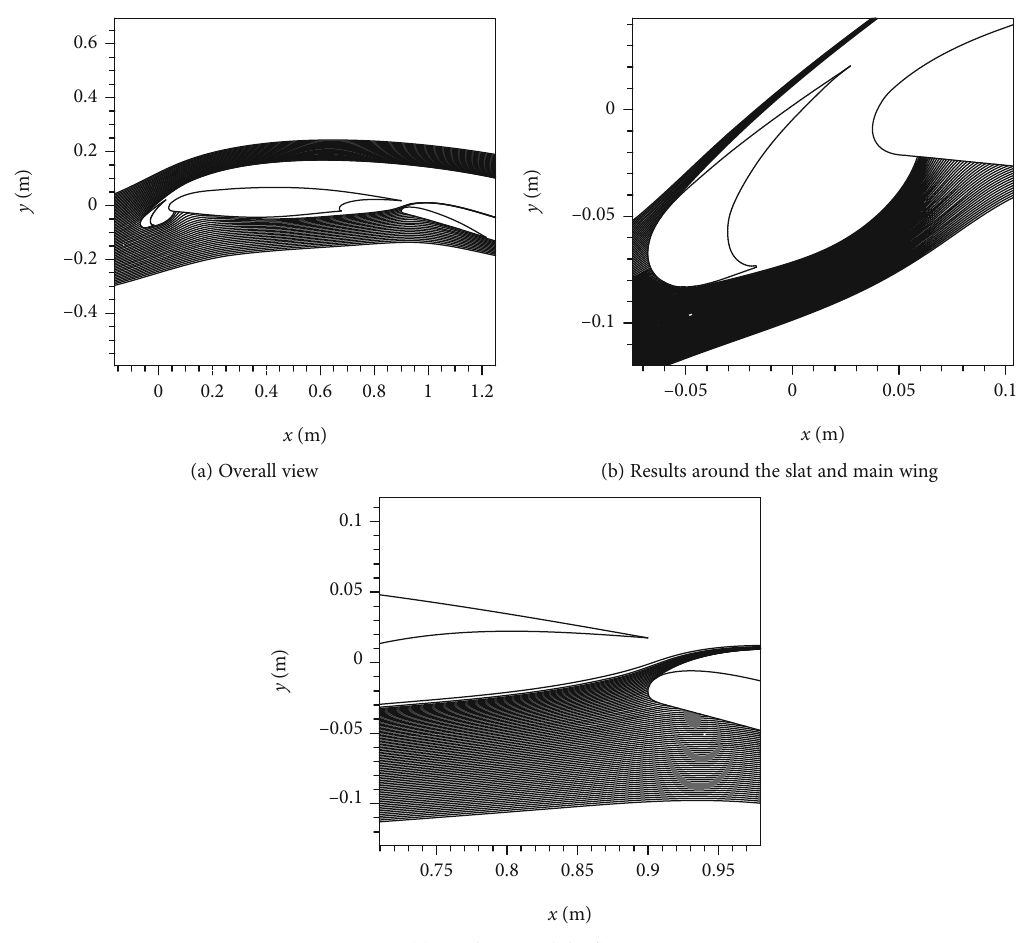
Figure 9: Lagrangian droplet trajectories around the multi-element airfoil at the droplet diameter of 20 μ